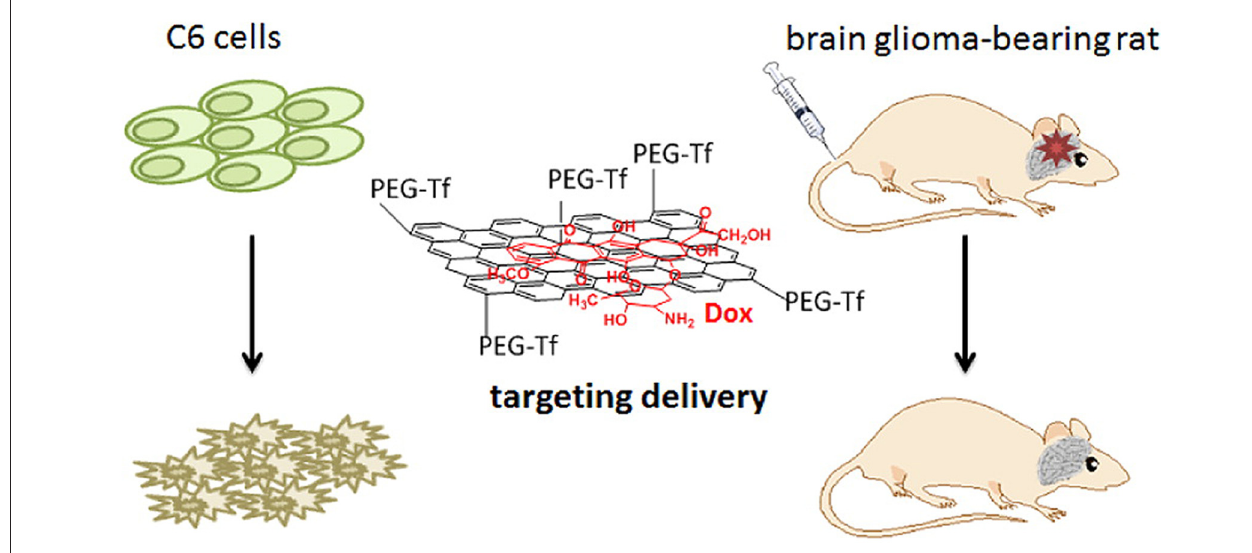
FIGURE 3 | Transferrin modified G oxide (GO) for glioma-targeted drug delivery. Modified with permission from Liu G. et al.